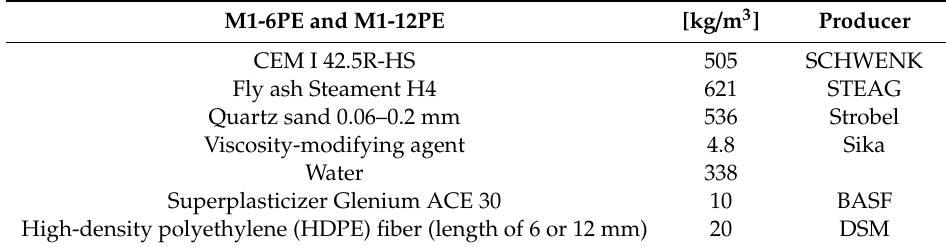
Table 1. Composition of the matrix and strain-hardening cement-based composite (SHCC) under investigation.